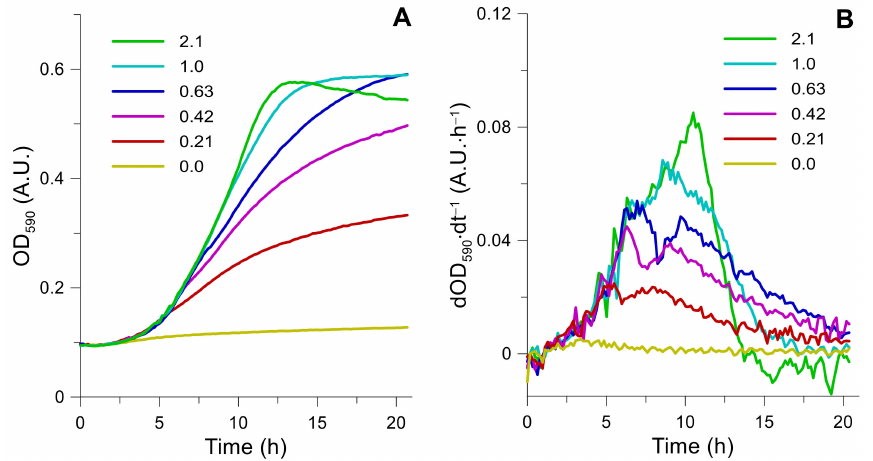
Figure 3. Urea limitation effect on K. marxianus biomass growth during micro-cultivations. Urea concentration varied from 0–2.1 mM, culture growth was recorded as OD 590 ( A ). Growth rate (first derivative) from the culture absorbance data was calculated and plotted over time ( B ). The tipping point of the first derivative trend is the moment when the limiting nutrient is depleted. Each cultivation plot is the average of four parallel well measurements. Standard deviations are not shown, but they do not exceed